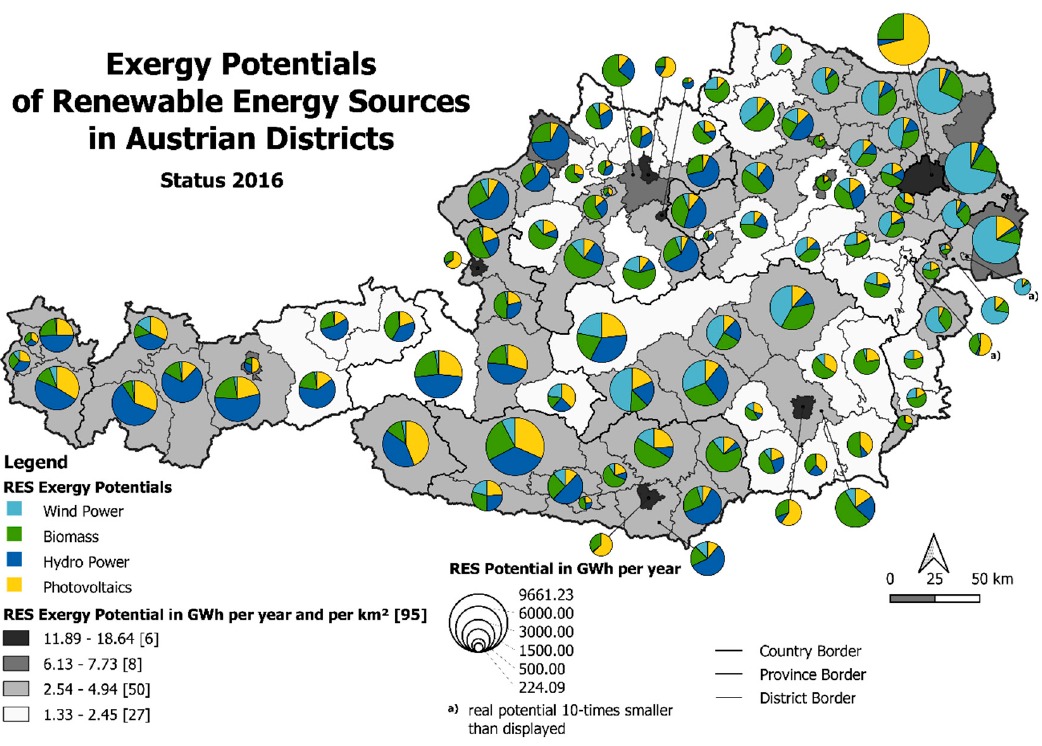
Figure 9. Exergy potential of RES in Austria per district. Apart from cities, the potential of RES is rather evenly distributed, even if the individual shares of the various RES per district vary (map source: Statistics Austria - data.statistik.gv.at).